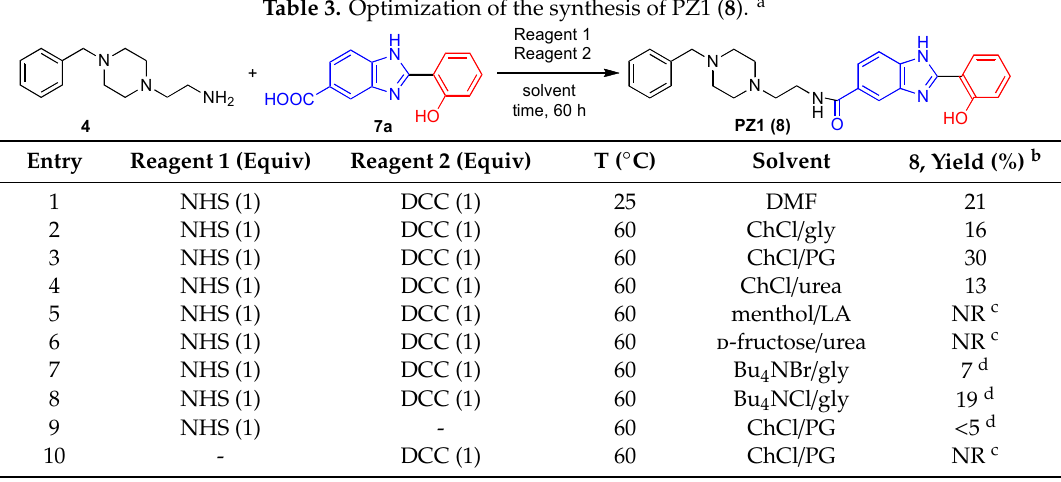
c No reaction. d Calculated via 1 H ‐ NMR analysis of the crude reaction mixture using an internal standard technique (NMR internal standard: